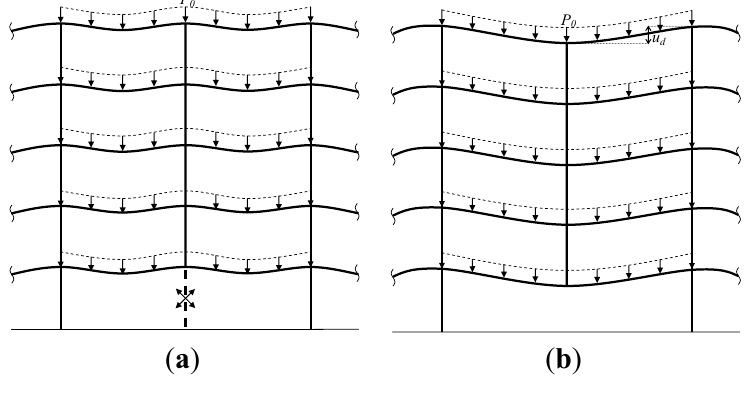
Figure 2. Multi-story building under column loss. ( a ) Initial deformed shape ( ) ( b ) Maximum dynamic response